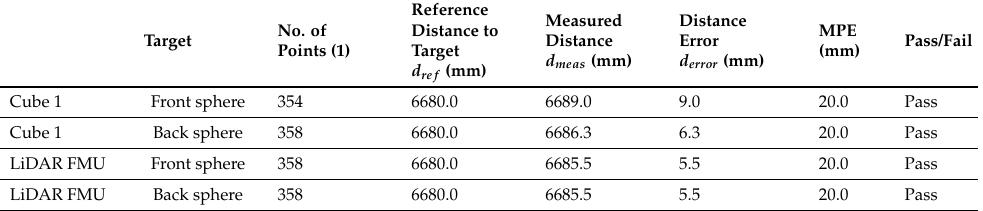
Table 3. Inside test